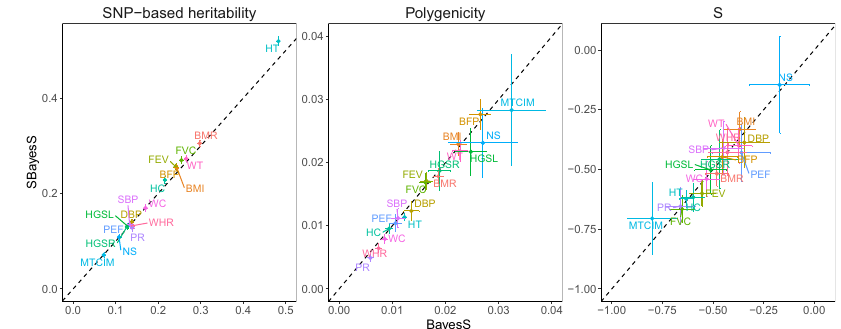
Fig. 1 Benchmarking SBayesS with BayesS using the same data for 18 UKB traits. Three genetic architecture parameters were compared, i.e., SNP-based heritability, polygenicity (de fi ned as proportion of SNPs with nonzero effects) and S (de fi ned as relationship between MAF and effect size), based on the unrelated individuals of European ancestry in the interim release of the UKB data (max n = 120k) and ~1.1 million HapMap3 common SNPs (MAF > 0.01). The sparse LD matrix used in SBayesS was computed from a random sample of 50k unrelated individuals from the full UKB cohort at a chi-squared threshold of 10 (corresponding to a LD r 2 threshold of 2 × 10 − 4 ). Data are presented as posterior means ± posterior standard errors. The traits are indicated by different colours labelled with their acronyms. BMR basal metabolic rate, BMI body mass index, BFP body fat percentage, DBP diastolic blood pressure, FEV forced expiratory volume, FVC forced vital capacity, HGSL hand grip strength (left), HGSR hand grip strength (right), HCadjBMI hip circumference adjusted for BMI, HT height, MTCIM mean time to correctly identify matches, NS neuroticism score, PEF peak expiratory fl ow, PR pulse rate, SBP